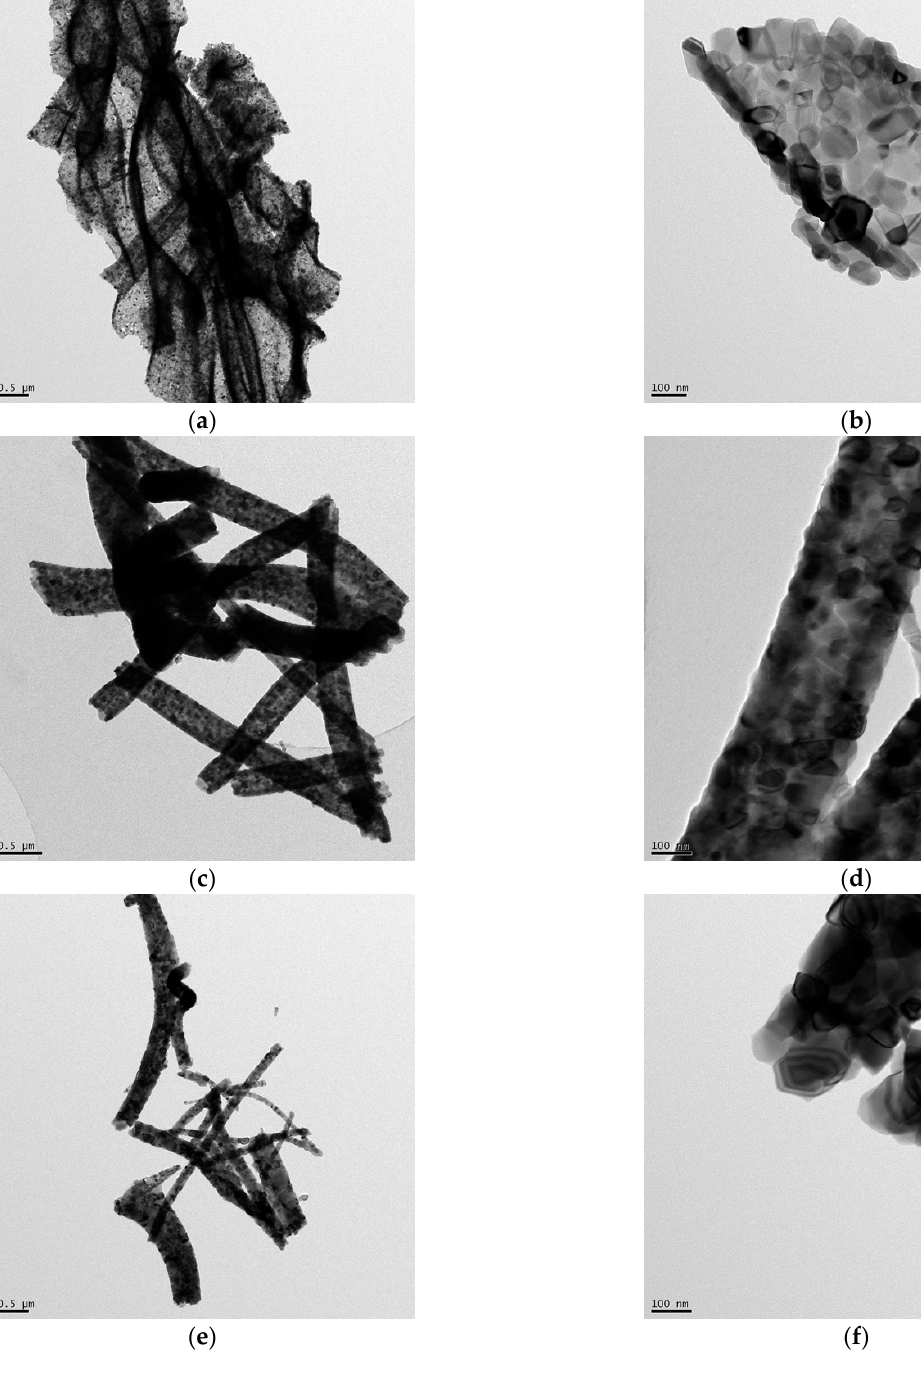
Figure 5. TEM images of fiber samples with low, medium, and high recipes with 2400 °C/h heating rate without soaking. (R2400-0h) . ( a , b ) Low, ( c , d ) Medium, and ( e , f ) High.